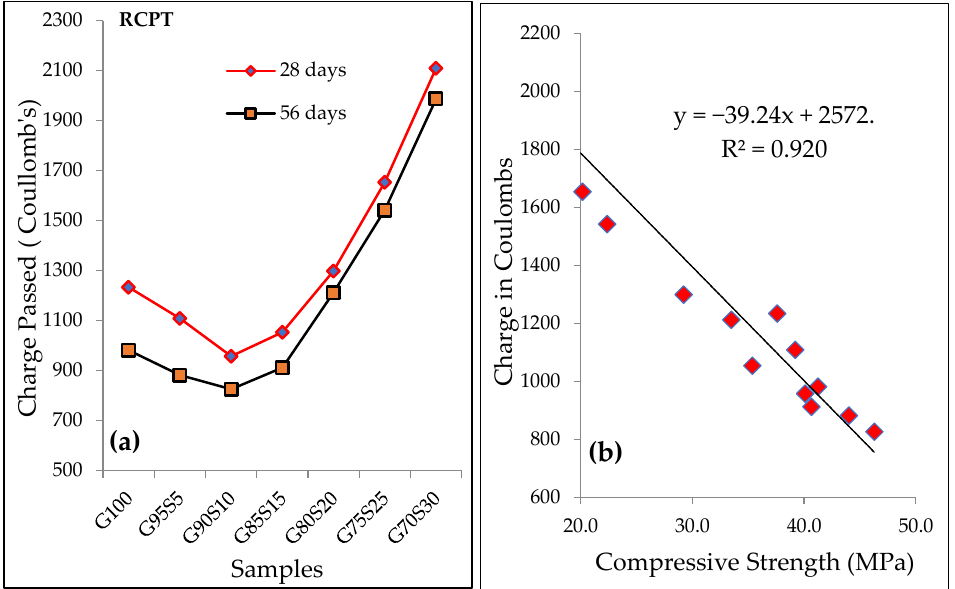
Figure 5. ( a ) RCPT test results; ( b ) correlation of compressive strength with RCPT value.